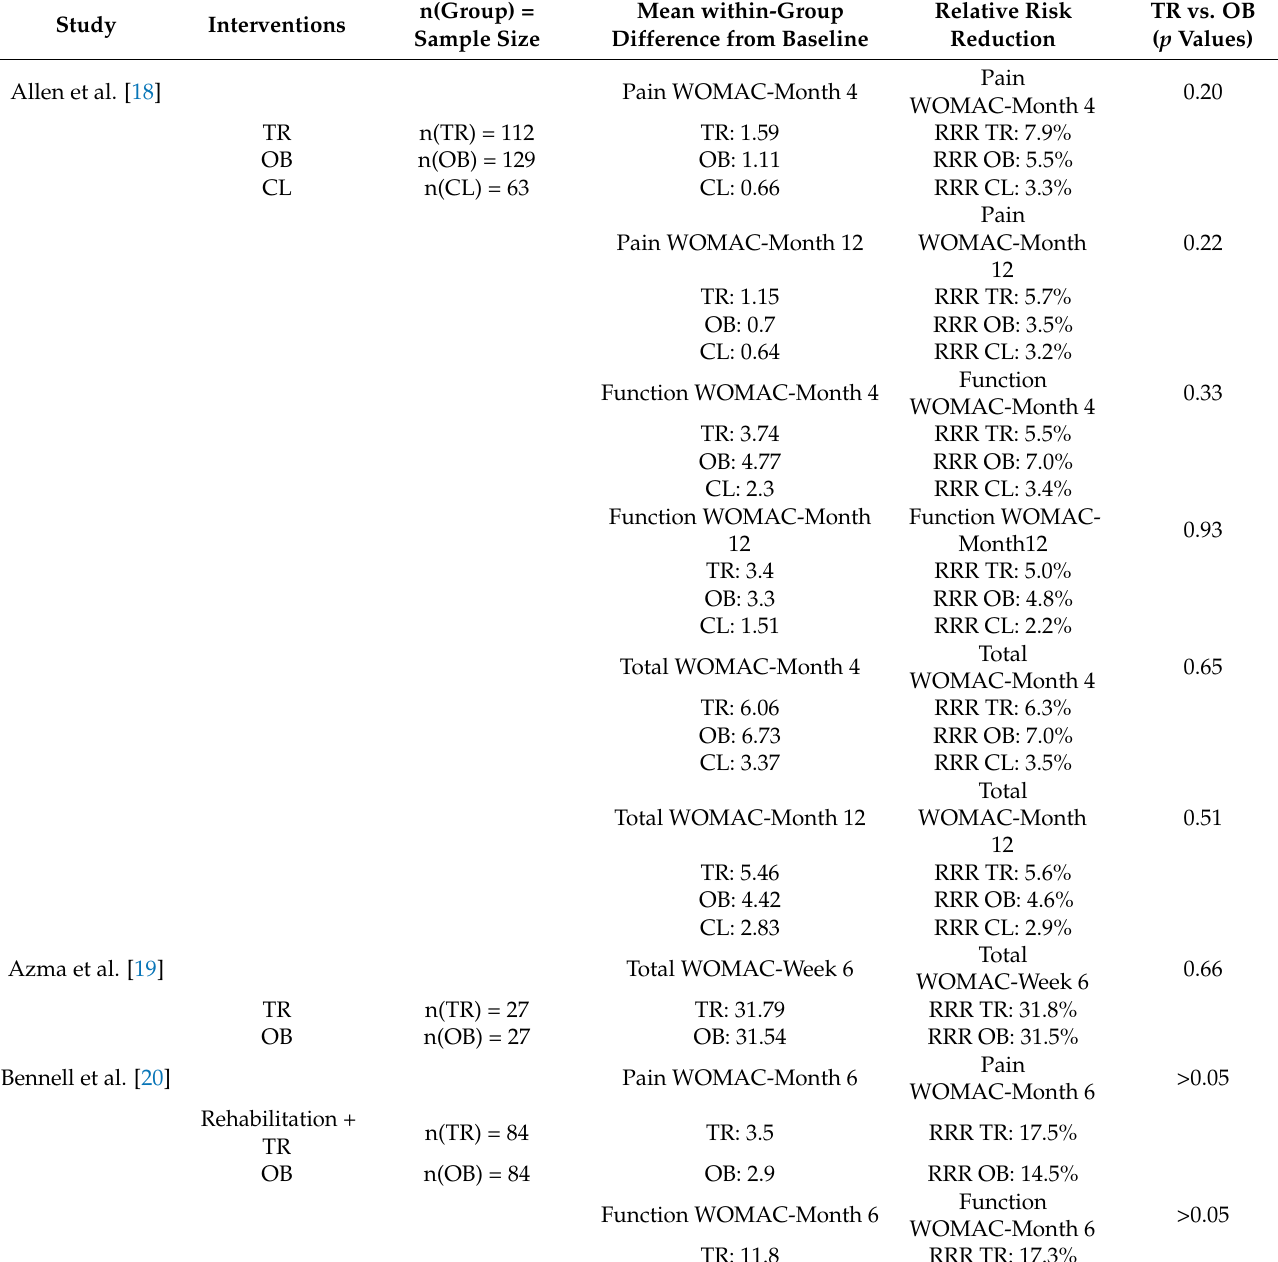
Table 2. Summary of results from the eligible studies (tele-rehabilitation (TR); office-based rehabilitation (OB); control (CL); WOMAC (Western Ontario and McMaster Universities Osteoarthritis Index); relative risk reduction (RRR)).